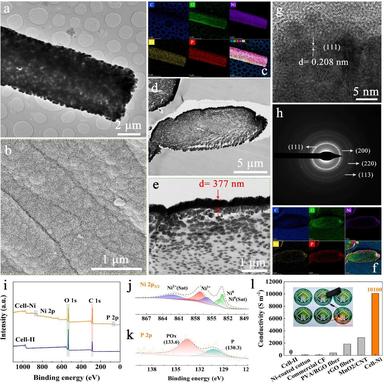
Morphology, structure, and conductivity of Cell-II and Cell-Ni. (a) TEM image of a single Cell-Ni fiber. (b) SEM image of Cell-Ni surface at magnification. (c) TEM elemental mapping images of a single Cell-Ni fiber. (d) Cross-section, (e) magnified image, and (f) elemental maps of a single Cell-Ni fiber. (g) HRTEM image of Ni layer showing the (111) lattice plane of Ni and (h) the corresponding SAED image. (i) XPS survey spectra of Cell-II and Cell-Ni. (j) Ni 2p and (k) P 2p XPS spectra of Cell-Ni. (l) Elec